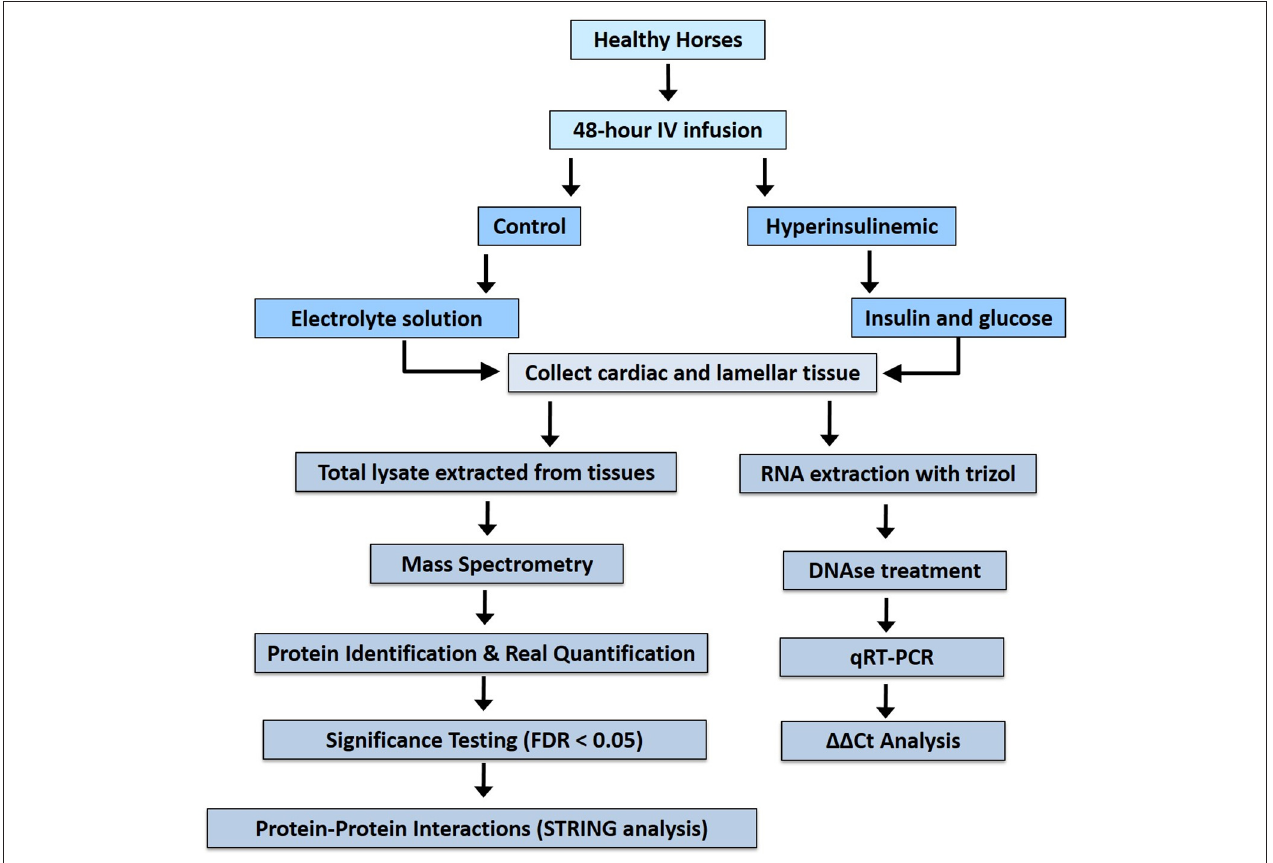
FIGURE 1 | Work flow for proteomic analysis of tissues from hyperinsulinemic horses and real-time reverse-transcriptase